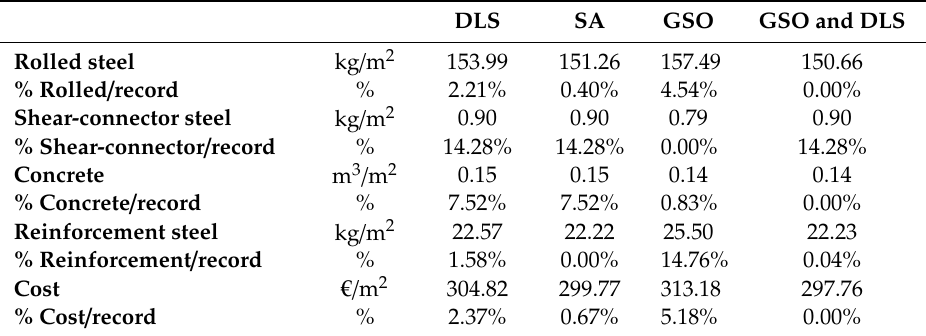
Table 5. Cost and material amount for the best heuristic solutions.